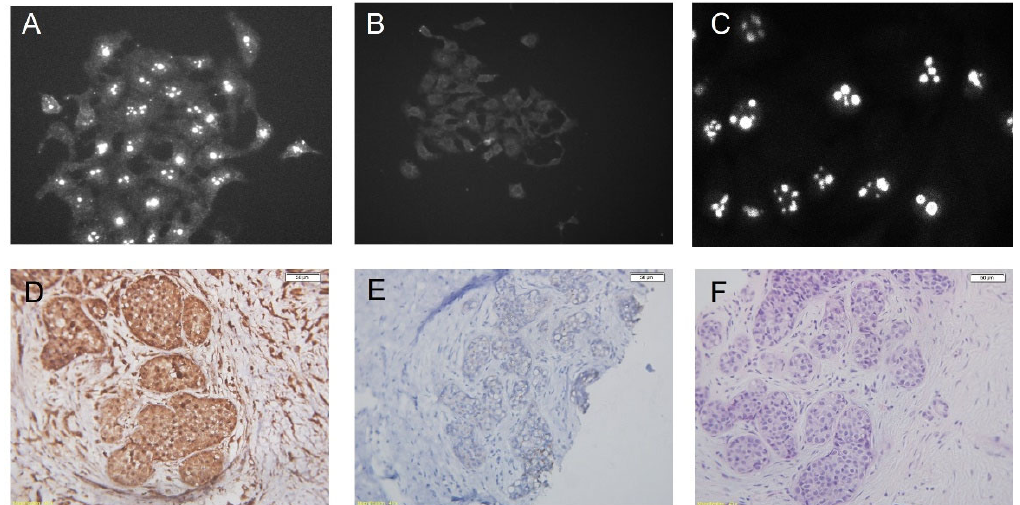
Figure 5. In vitro and b in vivo staining of p14. ( A – C ): Immune fluorescence (using Mab M202) of cultured MCF-7 cells that ectopically express p14, and parental MCF-7 cells that lack p14 and T-25 cells that contain p14, respectively. ( D – F ): Immunohistochemistry (peroxidase labeling) of a primary human breast tumor using polyclonal anti-p14 antibodies: ( D )—Anti-p14 antibody; ( E )—Control, no first antibody; ( F )—H&E staining of the tumor. Bars—50 μ m.